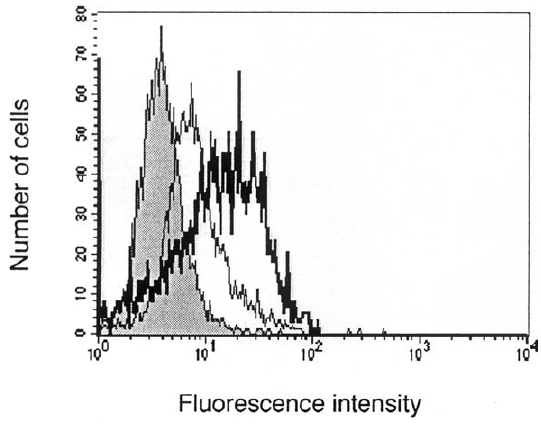
FIG. 6. Effect of H 2 O 2 on CCR5 protein expression. Mono- cytes were treated with 200 m M of H 2 O 2 for 4 h in serum-free medium and centrifuged for 5 min at 1000 rpm. The medium was then replaced by new medium and the cells were incubated for 16 h. The medium was then removed by aspiration without centrifugation. Cells were labelled with either an irrelevant antibody (shaded) or anti-CCR-5 (2D7) antibody, followed by FITC-conjugated goat anti-mouse antibody. Cells were analysed by flow cytometry (untreated cells, thin line; H 2 O 2 -treated cells, thick line). A representative experiment of nine independent experiments is